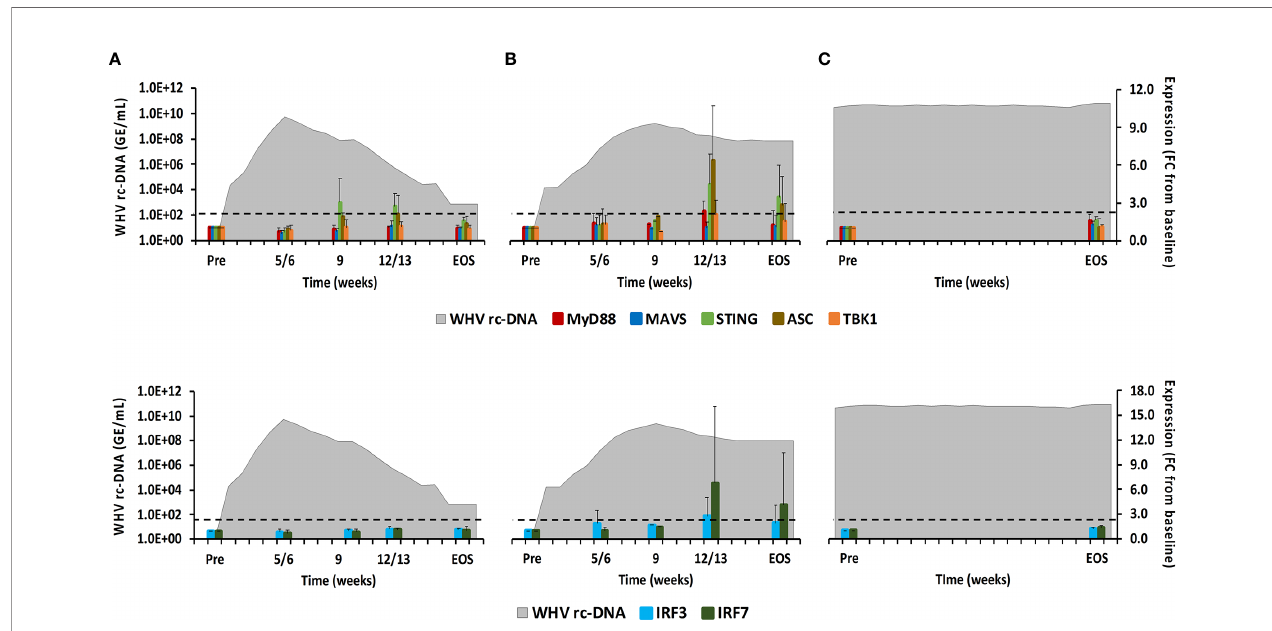
FIGURE 8 | Intrahepatic adaptor molecule and transcription factor expression. Expression changes of adaptor molecules MyD88, MAVS, STING, ASC, and TBK1 (top panels) and transcription factors IRF3 and IRF7 (bottom panels) in liver with WHV rc-DNA kinetics of woodchucks during (A) AHB with normal resolution (n=5), (B) AHB with delayed resolution (n=5), and (C) CHB progression (n=3). The fold-changes in adaptor molecule and transcription factor transcript level are plotted on the right y-axis, while serum WHV rc-DNA loads are plotted on the left y-axis. The horizontal, dotted line indicates the cutoff for positive expression (i.e., ≥ 2.1-fold increase from the pre-inoculation baseline). Horizontal bars represent the standard error of the mean. Pre, pre-inoculation for AHB and start of study for CHB; EOS, end of study; FC,